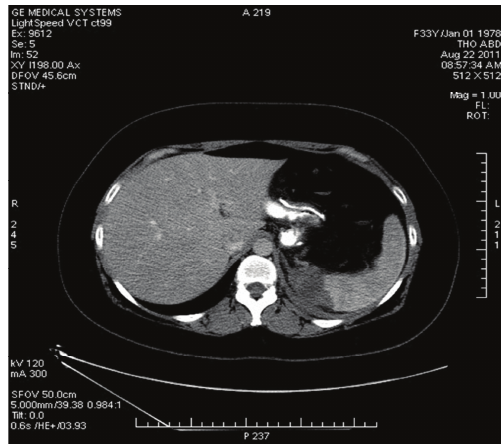
Figure 1: Oral and intravenous contrast abdominal multidetector CT scan showing infarction of the upper-medial part of the spleen and the adjacent gastric sleeve.